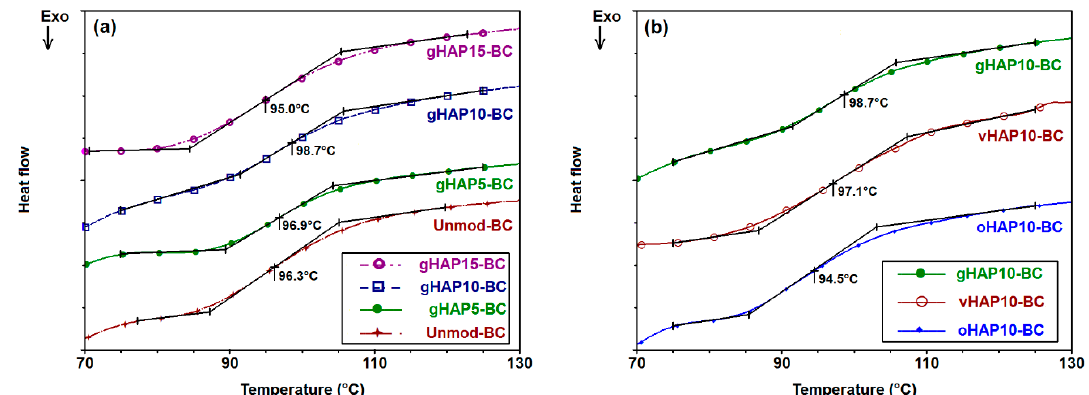
Figure 16. ( a ): DSC diagrams of gHAP-BC samples modified with gHAP loadings of 0, 5, 10, 15 wt.%, labeled as unmodified-BC, gHAP5-BC, gHAP10-BC and gHAP15-BC, respectively, and ( b ): DSC diagrams of bone cements modified with 10 wt.% of oHAP, vHAP and gHAP, labeled as oHAP10-BC, vHAP10-BC and gHAP10-BC, respectively.